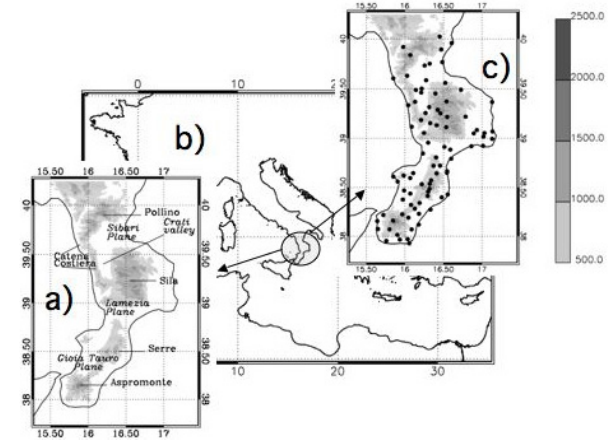
Figure 1. (a) Calabria features cited into the text; (b) Calabria region in the central Mediterranean; (c) Black-filled circles are the stations of the regional network. Grey shading shows the orographic height